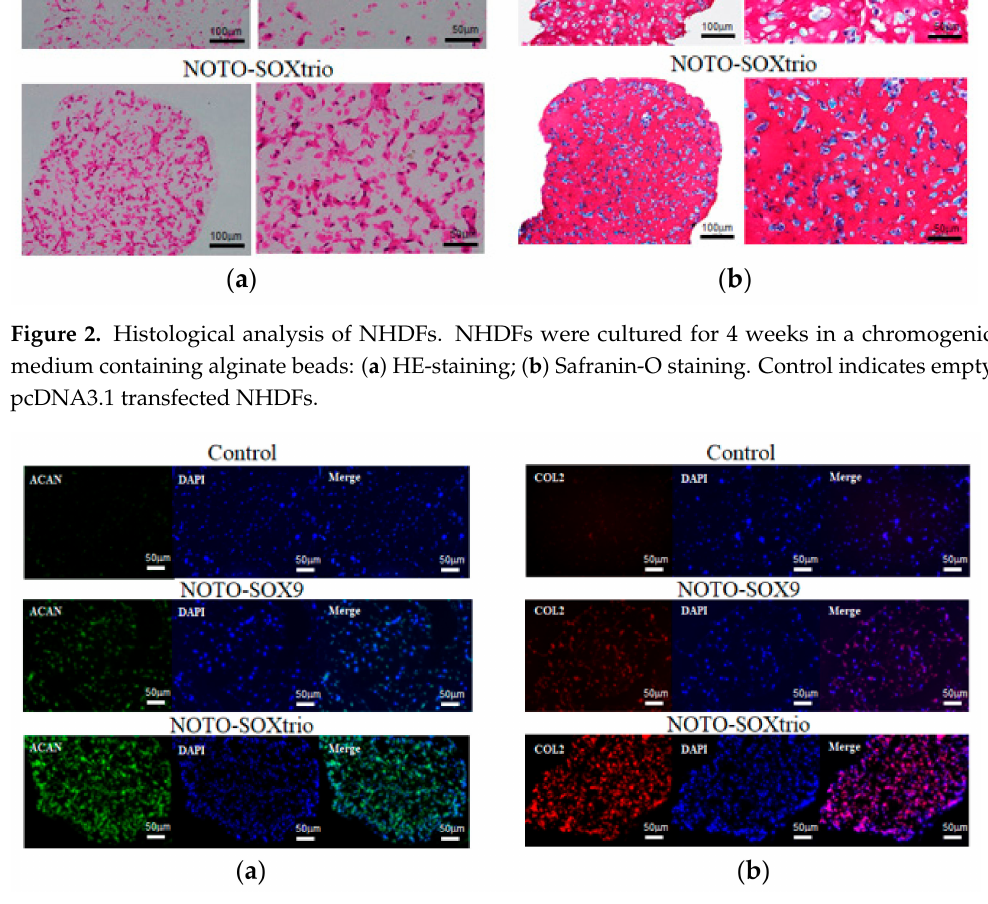
Figure 3. Immunofluorescence analysis of Aggrecan and type II collagen expression in NHDFs cul- tured with alginate beads. Paraffin-embedded, fixed sections were subjected to immunohistochemical analysis using antibodies specific for ACAN and type II collagen: ( a ) ACAN; ( b ) COL2. Control indicates empty pcDNA3.1 transfected